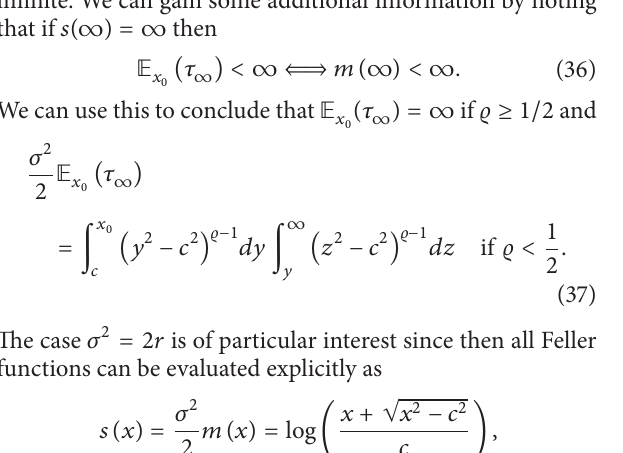
Figure 3: A simulated path of the price process. We plot 𝑋 𝑡 as a function of time during a time span of five years ( 𝑡 = 5 ). The parameters have been chosen as: 𝑟 = 4.5 % yr −1 , 𝜎 = 30 %, 𝑐 = 4 and 𝑥 0 = 5